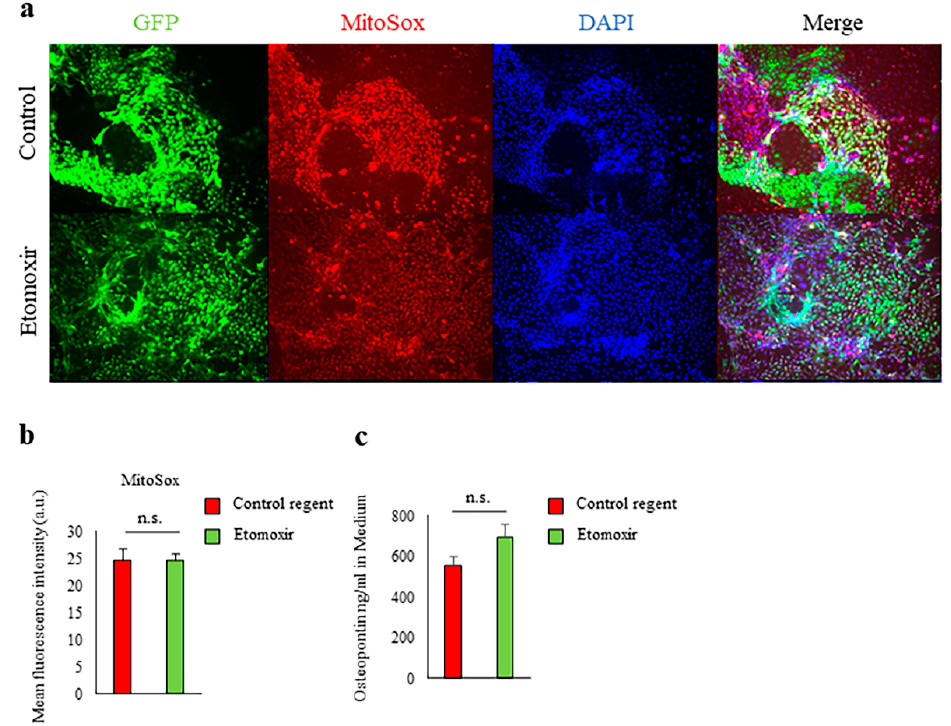
Figure 3. Fatty acid beta ‐ oxidation was not involved in Spp1 transcriptional activation in high ‐ glucose conditions. ( a ) Primary culture of proximal tubular epithelial cells (PTEC) derived from enhanced green fluorescent protein (EGFP) ‐ Spp1 knock ‐ in reporter mice. PTEC were cultured in 30 mM glucose conditions for 7 days with etomoxir or control regent. Microscopic analysis of fl uorescence of 4 ʹ ,6 ‐ diamidino ‐ 2 ‐ phenylindole (DAPI) and MitoSOX staining and of EGFP ‐ Spp1 expression. ( b ) Mean fluorescence intensity of MitoSox in PTEC ( n = 6 per group). ( c ) Osteopontin (OPN) in the culture supernatants was assessed by enzyme ‐ linked immunosorbent assay ( n = 6 per group). n.s., not significant. Data are shown as means, and error bars depict SEM.